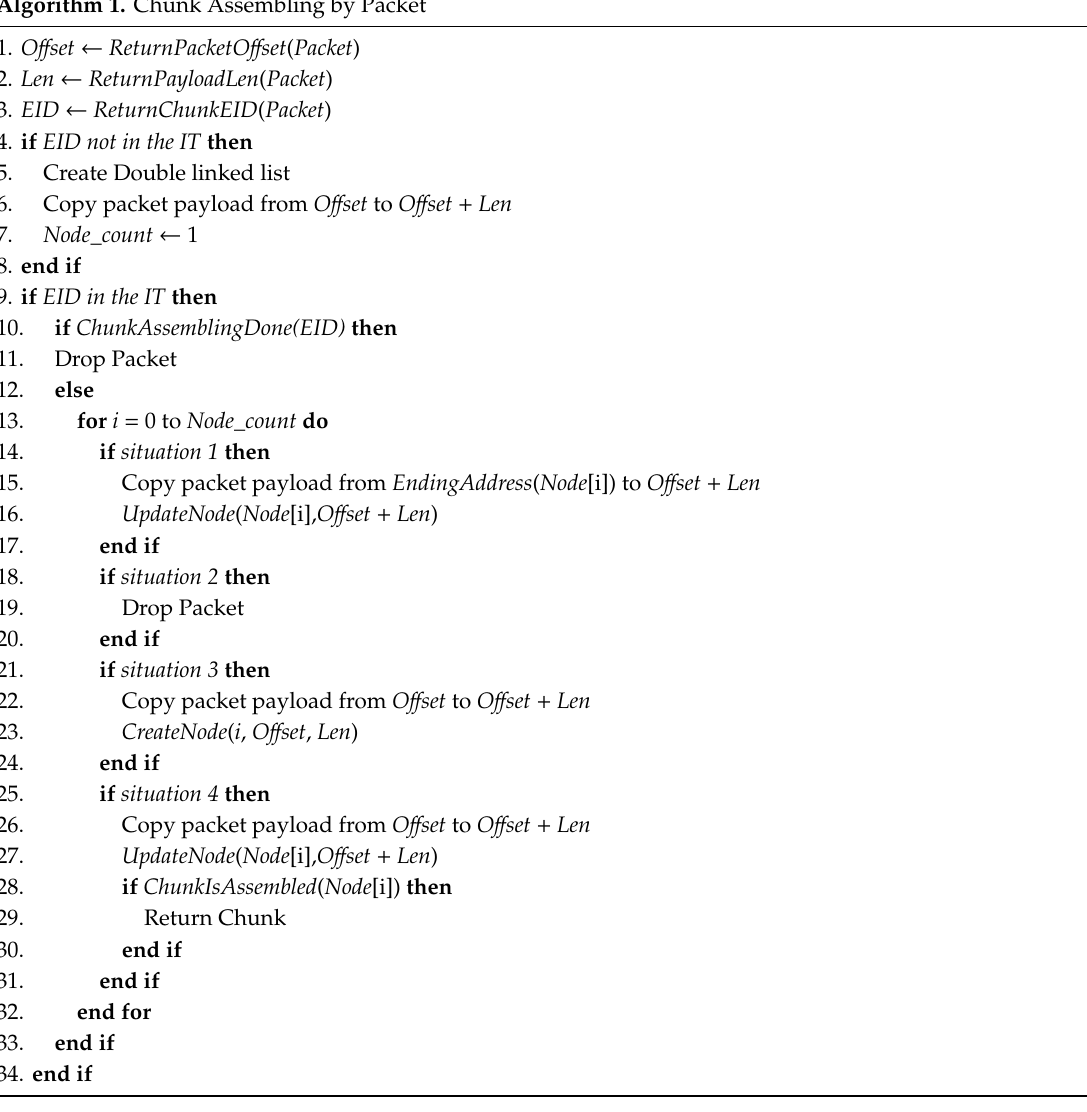
Algorithm 1. Chunk Assembling by